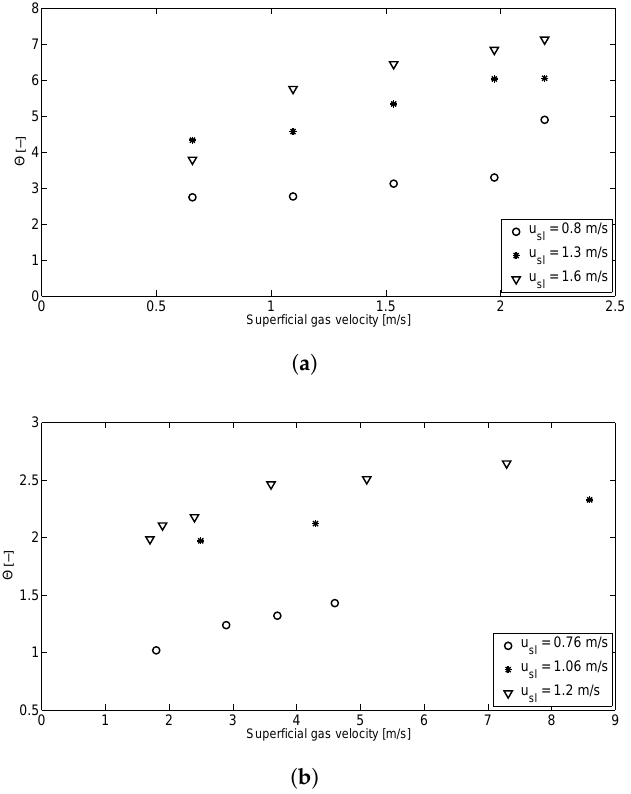
Figure 8. Dimensionless computational time Θ as a function of the superficial gas velocity: simulations with the lower superficial velocities are performed faster than real time. End time t = 300 s, ∆ x = D /2, CFL = 0.95. ( a ) Dimensionless computational time Θ for the simulations performed on Pipe1; and ( b ) Dimensionless computational time Θ for the simulations performed on